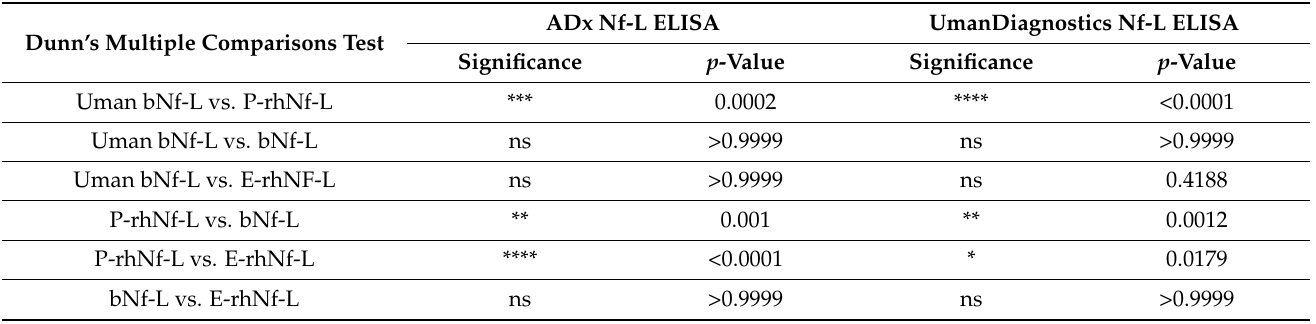
Table 6. Comparison of primary calibrators by ADx Nf-L ELISA and UmanDiagnostics Nf-L ELISA in 14 unclassified CSF